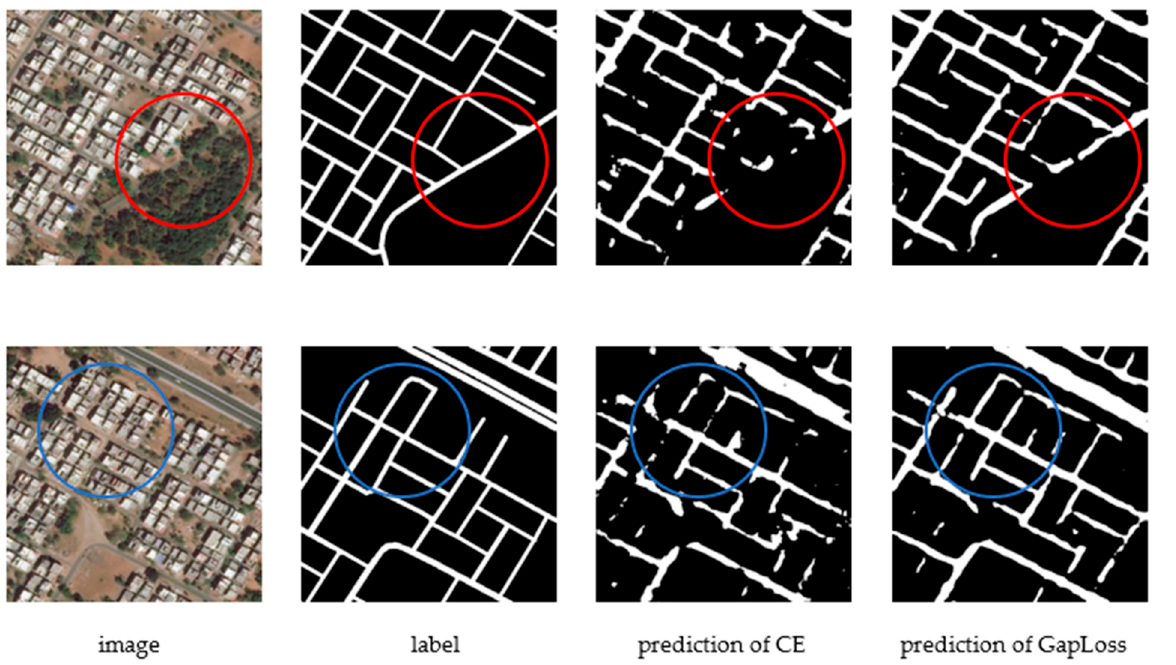
Figure 8. UNet++ results with CE and GapLoss on DeepGlobe Roads Dataset. The blue and red circles indicate where the road continuity is improved after using GapLoss.